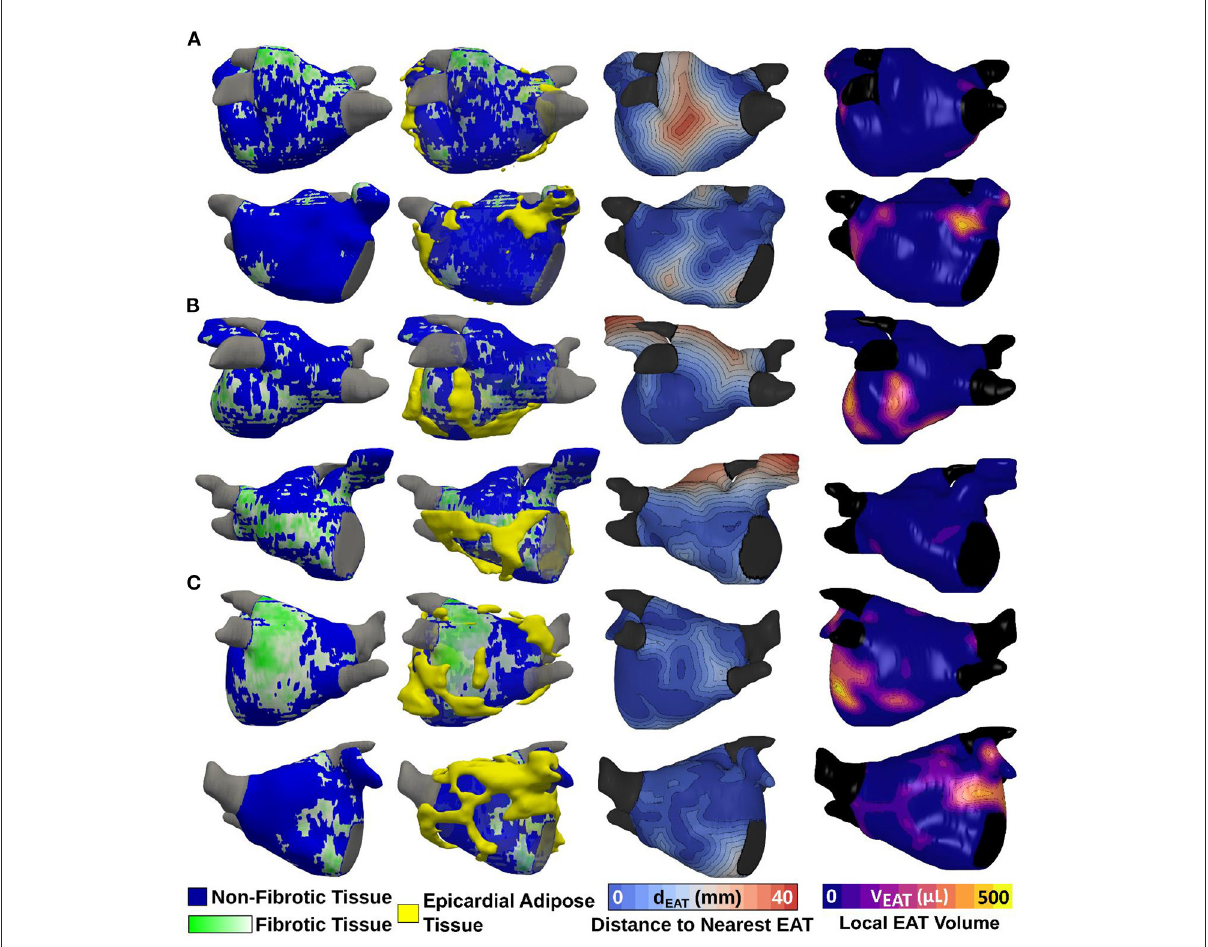
FIGURE5 Spatial distribution of LA EAT and fibrosis, including maps of local EAT proximity and maps of local EAT volume for three different patients. 3D atrial models showing LGE fibrosis (first column) with superimposed 3D renderings of EAT (second column) are shown. Maps of local EAT proximity and local EAT volume are shown in the third and fourth column, respectively. The patient in (A) is an example of overlap between EAT and non-fibrotic areas. The patient in (B) shows more overlap between EAT and fibrotic areas whereas the patient in (C) demonstrates no distinct pattern of overlap. EAT, epicardial adipose tissue; LA, left atrial; LGE, late gadolinium